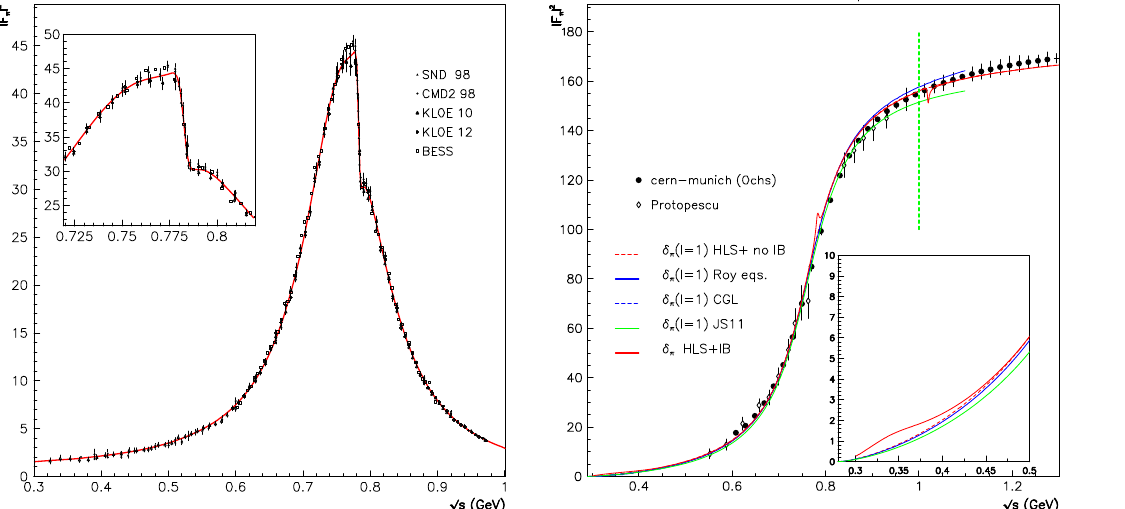
shift data and predictions from [62–65] and [66] together with the bro- ken HLS phase-shift. [Reprinted with permission from Ref. [61]. Copy- right (2015) by the European Physical Journal C (EPJ